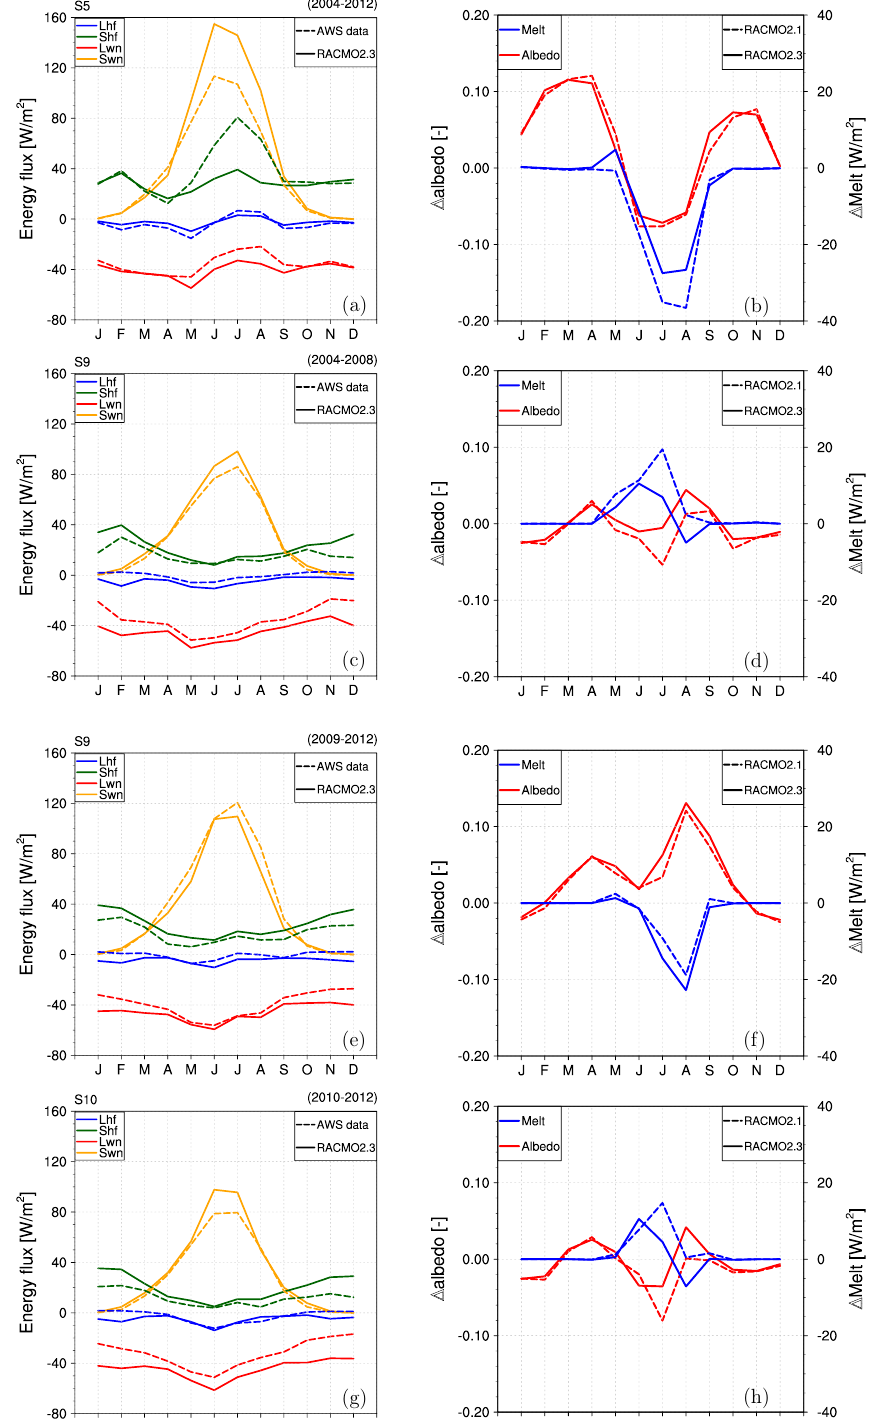
Figure 5. Observed and modelled turbulent and net shortwave/longwave fluxes (Wm − 2 ) at station (a) S5 for 2004–2012, (c) S9 for 2004– 2008, (e) S9 for 2009–2012 and (g) S10 for 2010–2012; difference in modelled and observed surface albedo and surface melt energy (Wm − 2 ) at stations (b) S5, (d) S9, (f) S9 and (h) S10 for the same